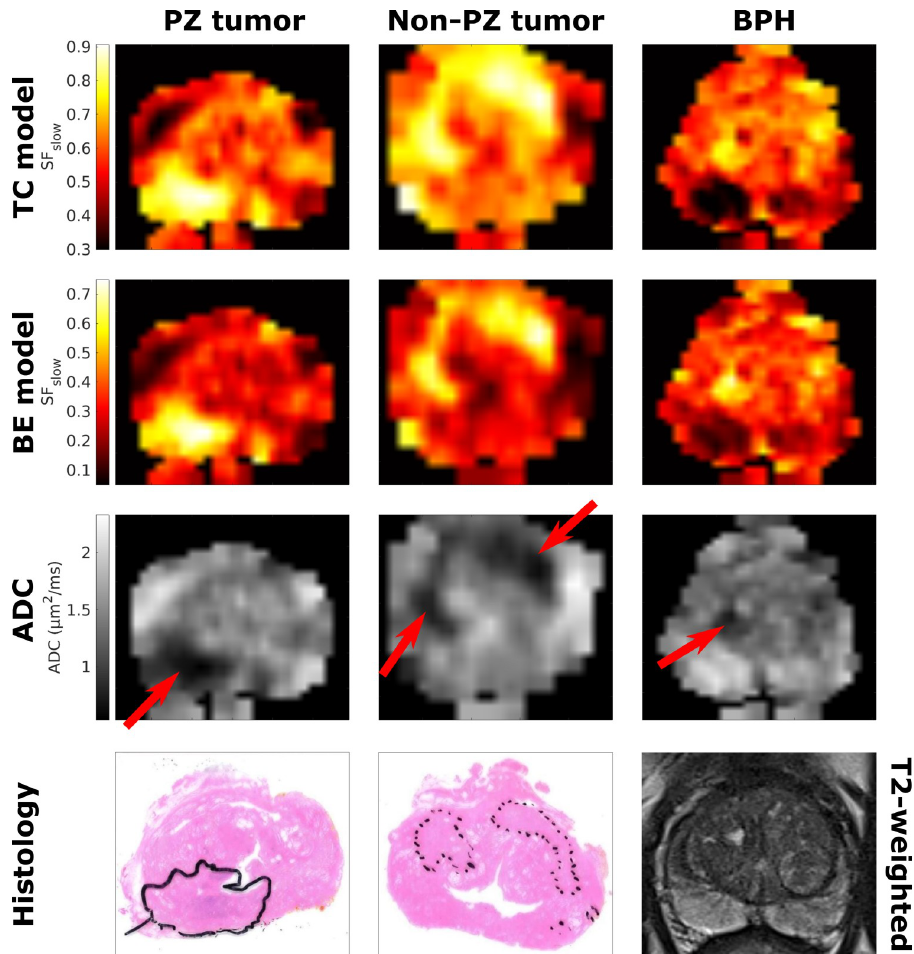
Fig 3. Examples of estimated value maps for three different patients. SF slow (from the two-component (TC) and bi- exponential (BE) models) maps and corresponding ADC map are shown for a PZ tumor patient, a non-PZ tumor patient and a BPH patient, respectively. For the tumor patients, histology slides are also shown for comparison, while a corresponding T2-weighted image is shown in the BPH case as histology was not available for this patient. The lesions are denoted on the ADC maps with red arrows. On the histology slides, the PZ tumor is denoted with a solid line, while the non-PZ tumors are denoted with dotted lines. Example maps from more cases can be found in the S2 Fig. Global T2 optimization was performed both to reduce the number of free variables and to isolate components with distinct, paired ADC and T2 values. Comparing the results with a model fit with the T2 values as free variables (see S1 Table) showed the benefit of optimizing the T2 values in advance. To further reduce the number of free variables, the ADCs were adapted from a bi-exponential model [19]. The signal fraction estimates for the slow compo- nent in that paper were markedly lower than our SF estimates from the two-component slow model, but closer to the values obtained with our bi-exponential model, indicating a depen- dence of SF on T2. This implies that the two-component and bi-exponential models do not slow isolate identical subvoxel populations of water molecules, because the added T2 dependence actively tunes the diffusion signal from the prostate tissue, in agreement with other studies per- formed with combined T2-DWI [12–14]. A previous three-component model based on com- bined T2-DWI estimated the T2 values of the epithelium, stroma and lumen to be 50 ms, 80